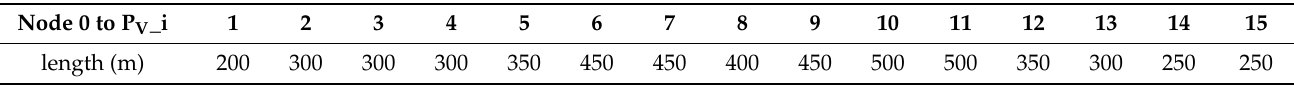
Table 3. Length of the Transmission